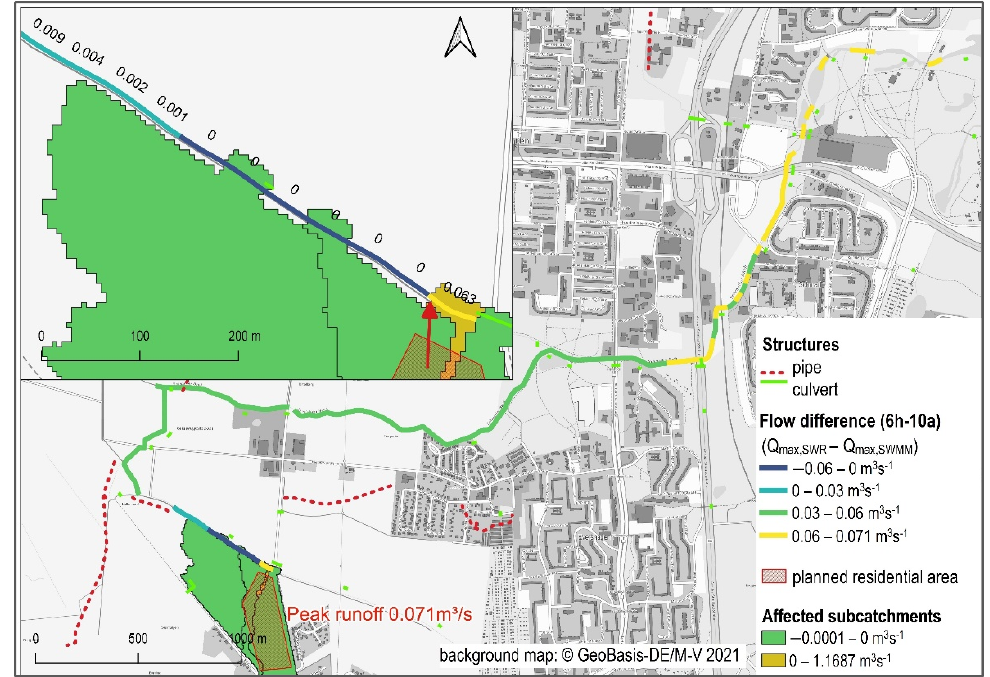
Figure 12. Peak runoff generated on the affected subcatchments and flow difference in m 3 s − 1 (Q plan state for the rain event 6 h–10